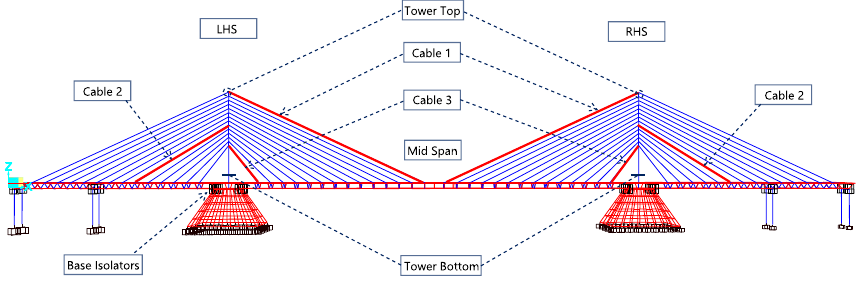
Fig. 4 Three‑dimensional model of the